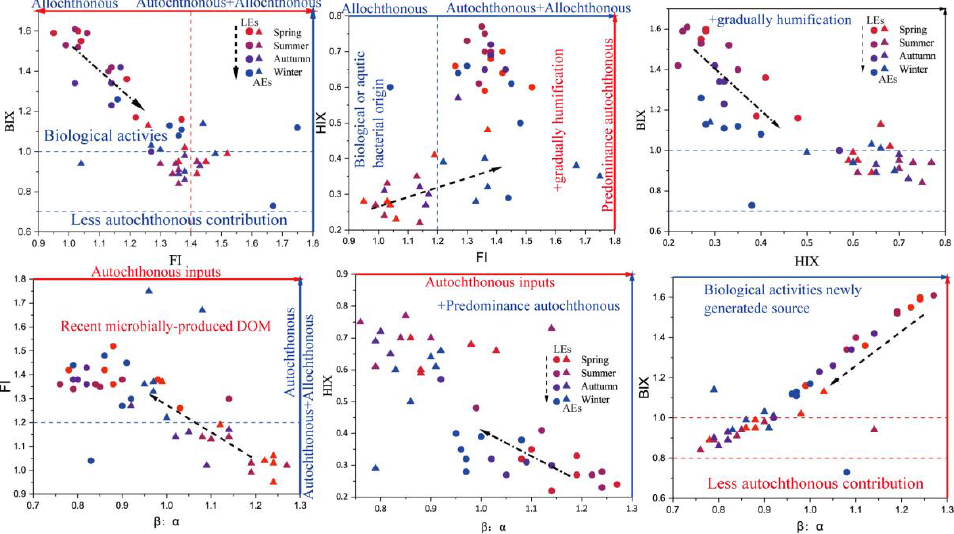
Figure 5. Relationship between FI, BIX, HIX, and β:α in AEs and LEs and variations with the season. The BIX indicates an autochthonous source of DOM when it is >0.8 [16,47]. All AE samples in this study had BIX values >0.8, while 95% of LE samples had BIX values >0.8, indicating that DOM in this study adds an autochthonous input to the microbial